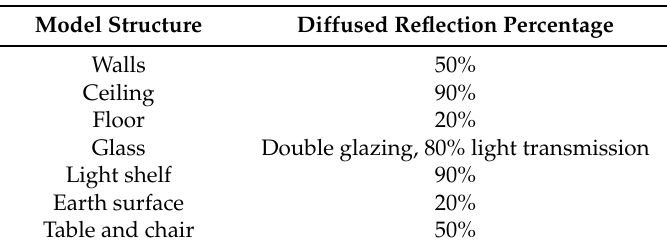
Table 2. The kind and amount of reflection on the surfaces of the studied classroom.